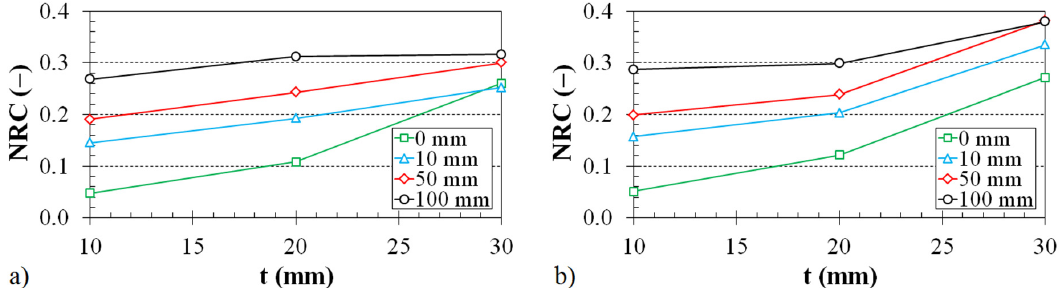
Figure 10. Noise reduction coefficient vs. material thickness dependencies for the investigated ABS samples with ( a ) Cartesian and ( b ) Octagonal structures. Inset legend: air gap size.